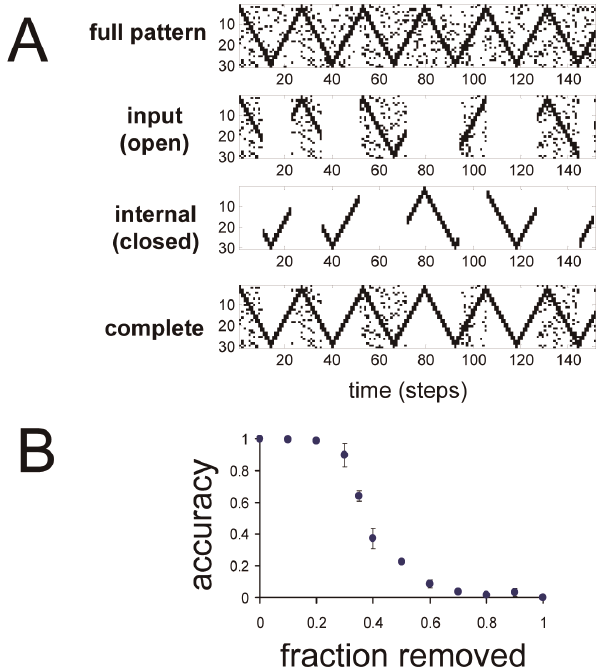
Figure 4. Robustness to sensory noise and synaptic perturba- tions. ( A ) Pattern of sensory environment with noise (full pattern), input activity during the open state (open), internal activity during the closed state (closed), and the combined (complete). ( B ) Match (accuracy) of internally generated activity to the missing input during the same interval versus fraction of random synapses removed. Accuracy is a conservative measure of how well internally generated patterns match the missing input during the same time interval. It is defined as one minus the fraction of discordant spikes between the missing input spike trains and the internally generated spike trains. The value here is the average for all thirty neurons. Accuracy can be negative in cases where internally generated activity is noisy and/or unstable.